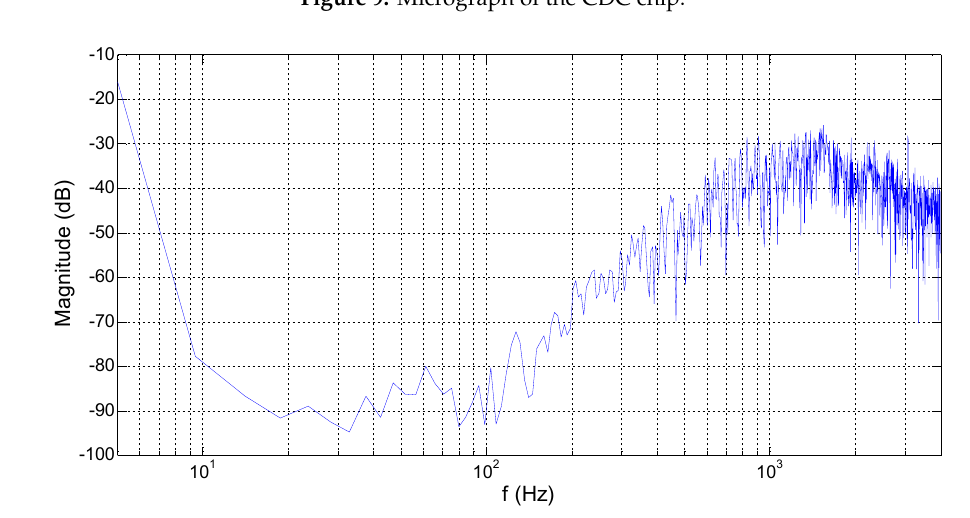
Figure 9. Micrograph of the CDC chip.